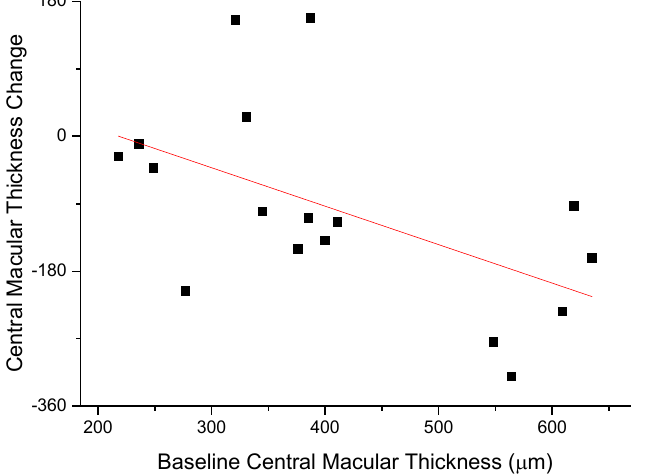
Figure 4. At the end of follow-up, the change in CMT was negatively correlated with baseline CMT (r= -0.53, p = 0.03).